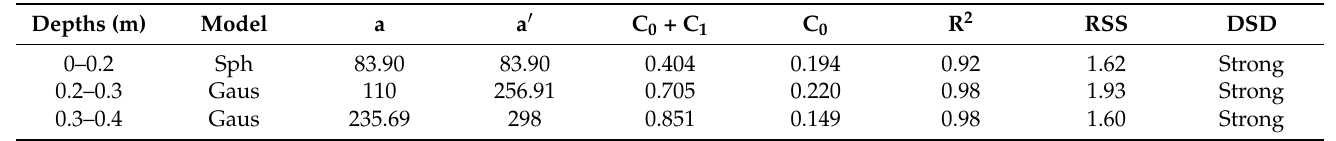
Table 3. Semivariogram models and parameters adjusted to values obtained from soil pH at soil